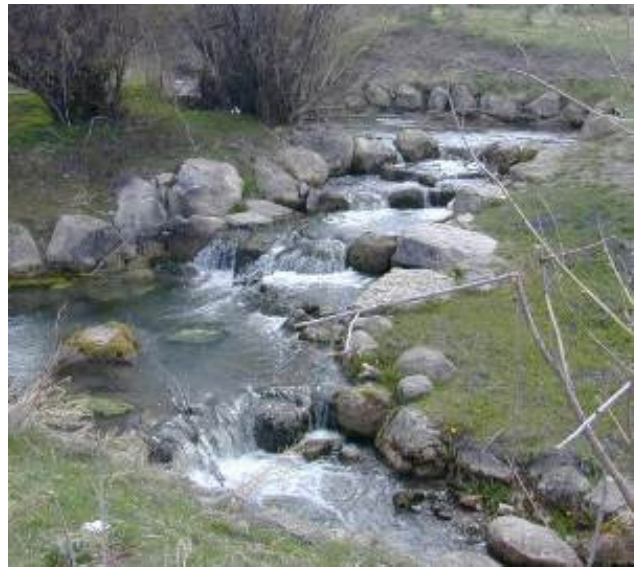
Figure 12. Constructed Step-Pool (photo courtesy of Rob Sampson).